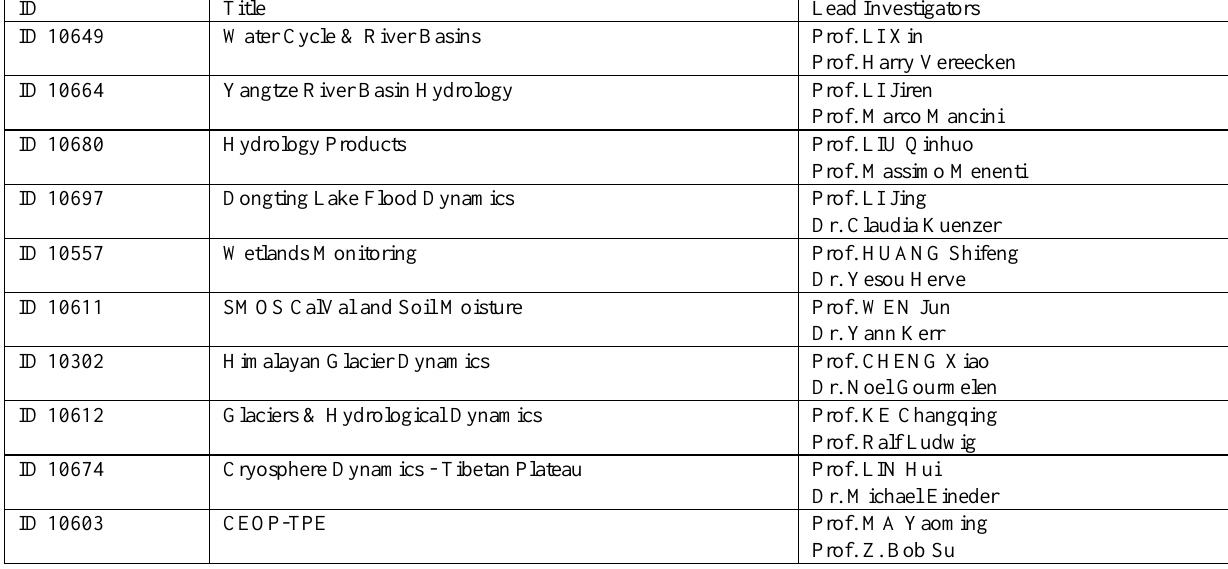
Table 1. Overview of Dragon 3 Projects addressing cryosphere and hydrosphere